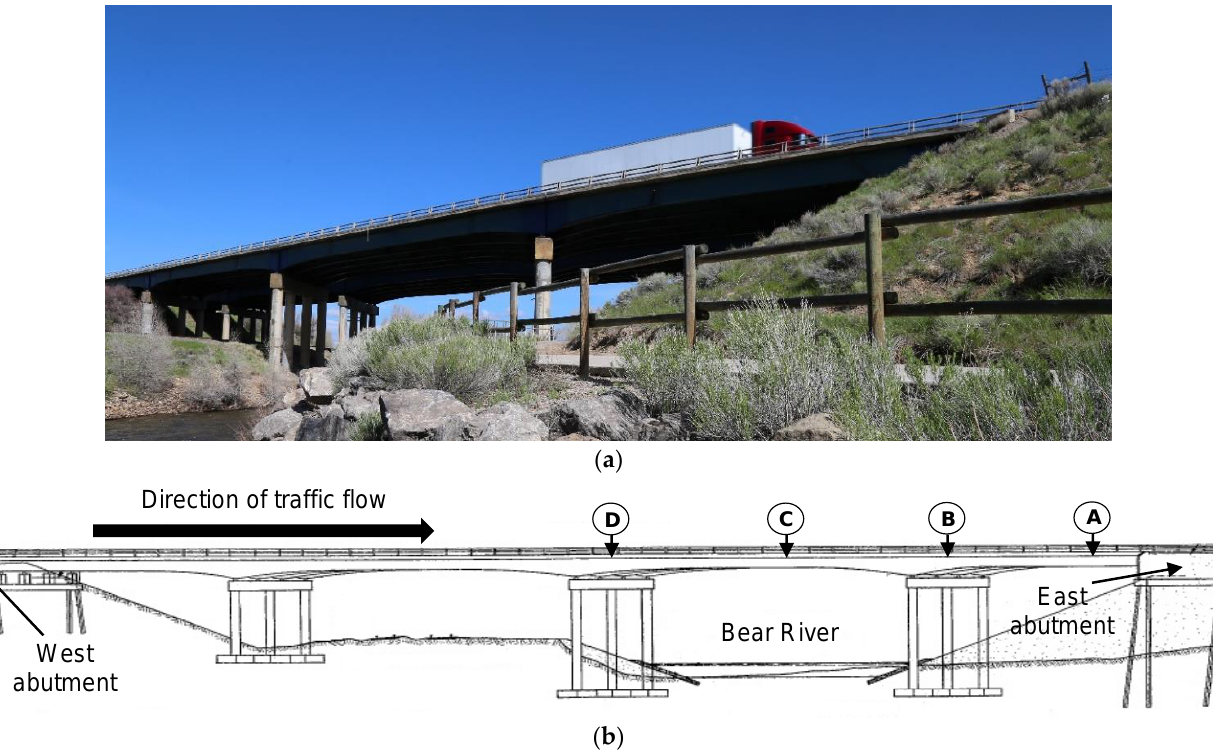
Figure 8. Bridge with flange-only array: ( a ) eastbound structure; ( b ) elevation drawing. The clear roadway width is approximately 12.2 m (40 ft) with curbs and barrier rails on the western side and just curbs on the eastern side. The spacing between girders is 2.74 m (9 ft). The deck thickness is 191 mm (7.5 in.) with a future wearing surface of 38.1 mm (1.5 in.) above it. At the eastern pier the girders are supported by a fixed bearing. The girders are supported by expansion bearings at the other abutment and at the interior piers. At the piers, the girders are spliced and the depth of the girders increases. The web and flange of the girders are thicker than the girders on the bridge span.